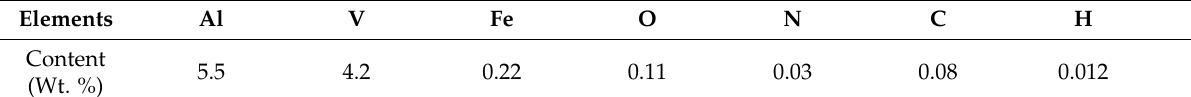
Figure 1. The experimental devices. Table 1. The material chemistry of the Ti-6Al-4V stock.